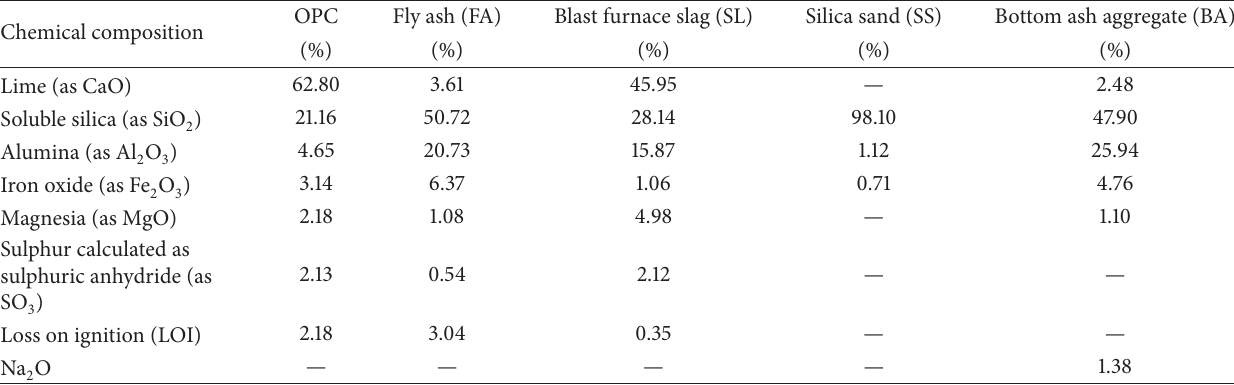
Table 1: Chemical composition of cement, SCMs, SS, and